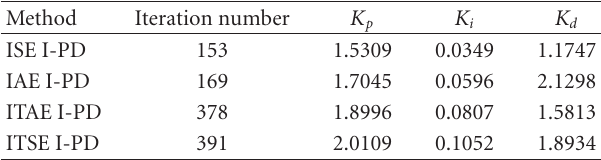
Figure 11: Load disturbance rejection for Example 1 with I-PD controller. Table 5: Optimised controller parameters.